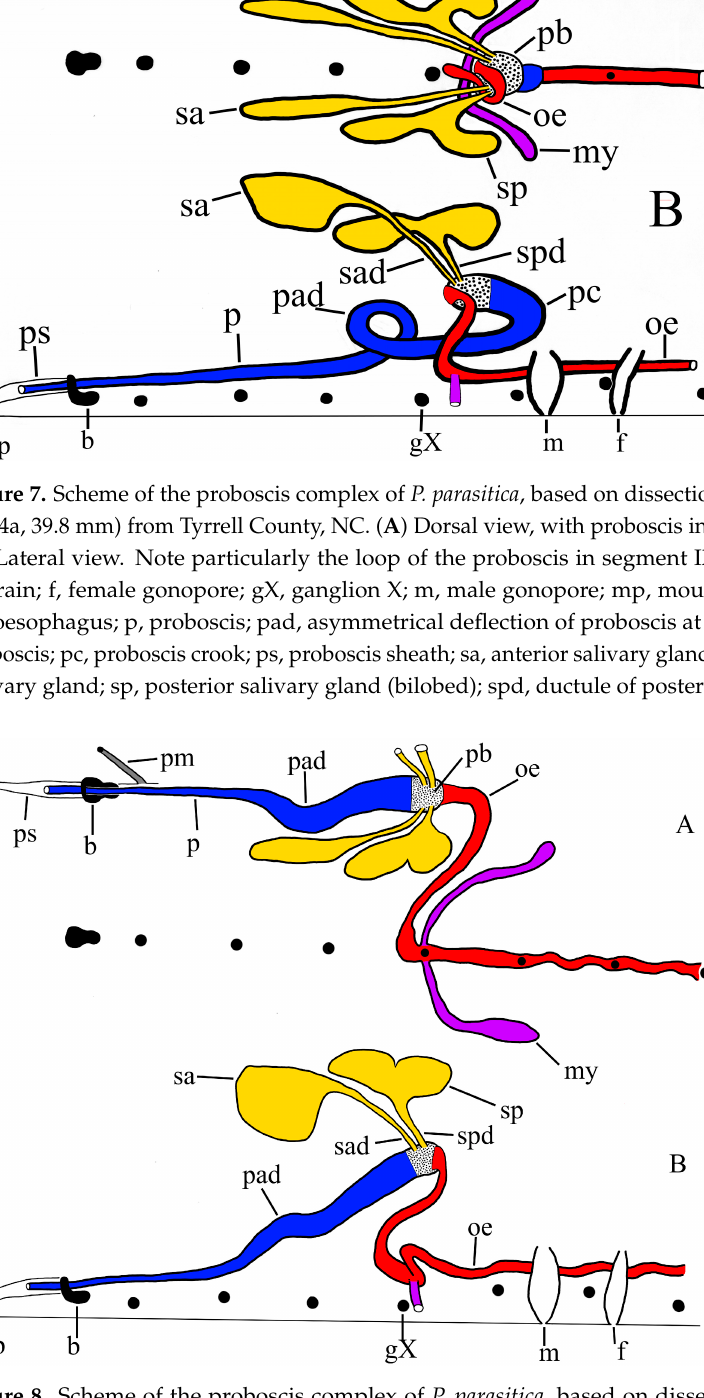
Figure 8. Scheme of the proboscis complex of P. parasitica , based on dissection of a post ‐ juvenile specimen (PP ‐ 2, 22.0 mm) from Tyrrell County, NC. ( A ) Dorsal view. ( B ) Lateral view. Note in this younger specimen the proboscis does not assume a full loop in segment IX, nor is there a crook of the base of the proboscis, but the other morphologic features remain constant, most notably the independent insertion of the salivary ductules. Abbreviations: pm, protractor muscle; others same as Figure 7.